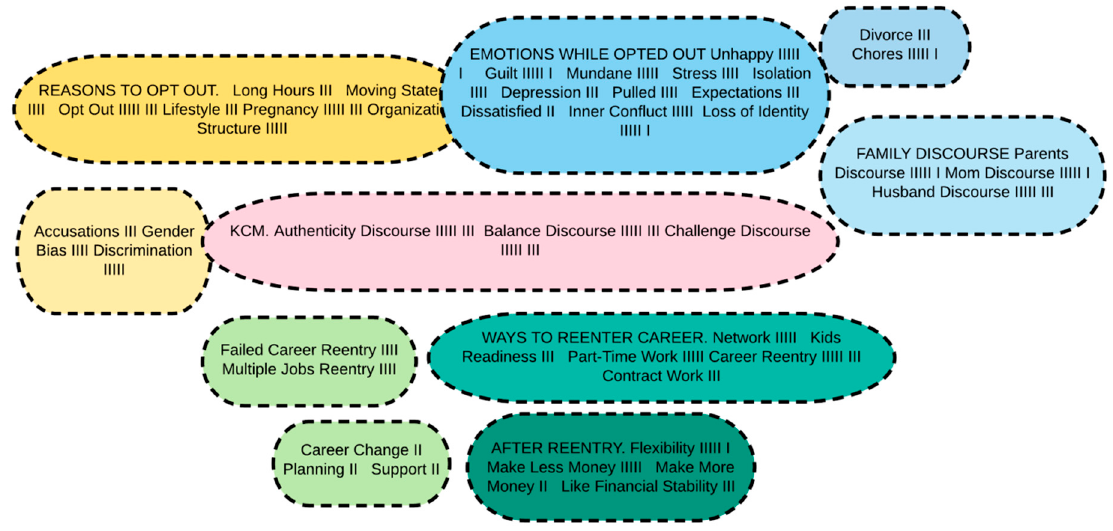
Figure 1. Primary researcher’s evolved meta situational map.